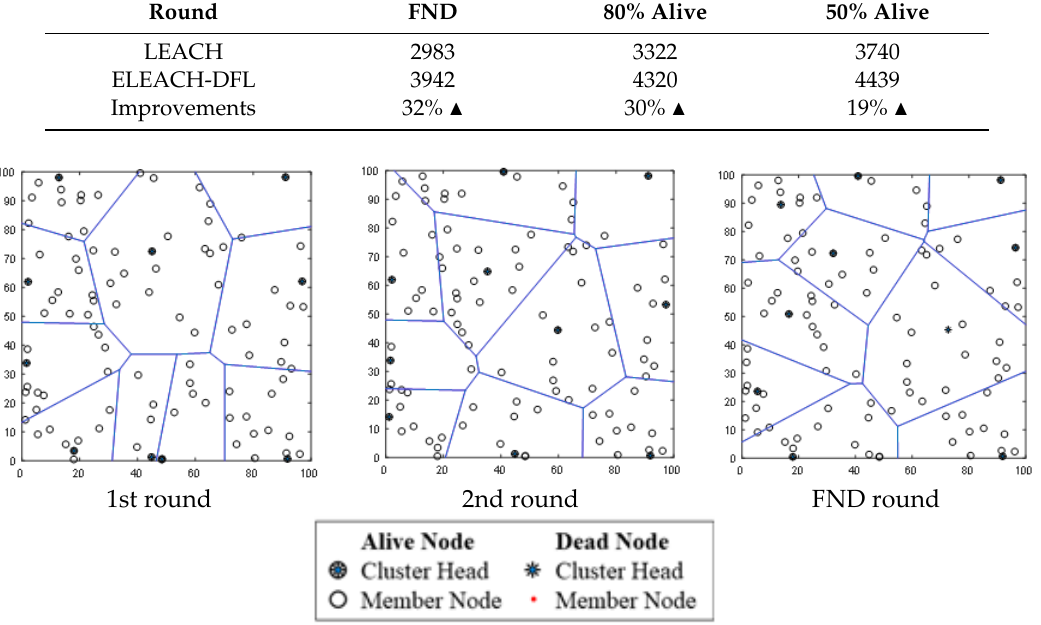
Figure 12. Constellation of nodes and clusters’ configuration.